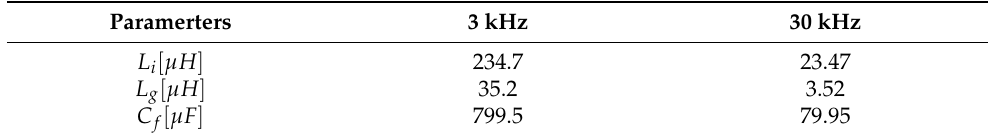
Table 4. LCL filter parameters for different switching